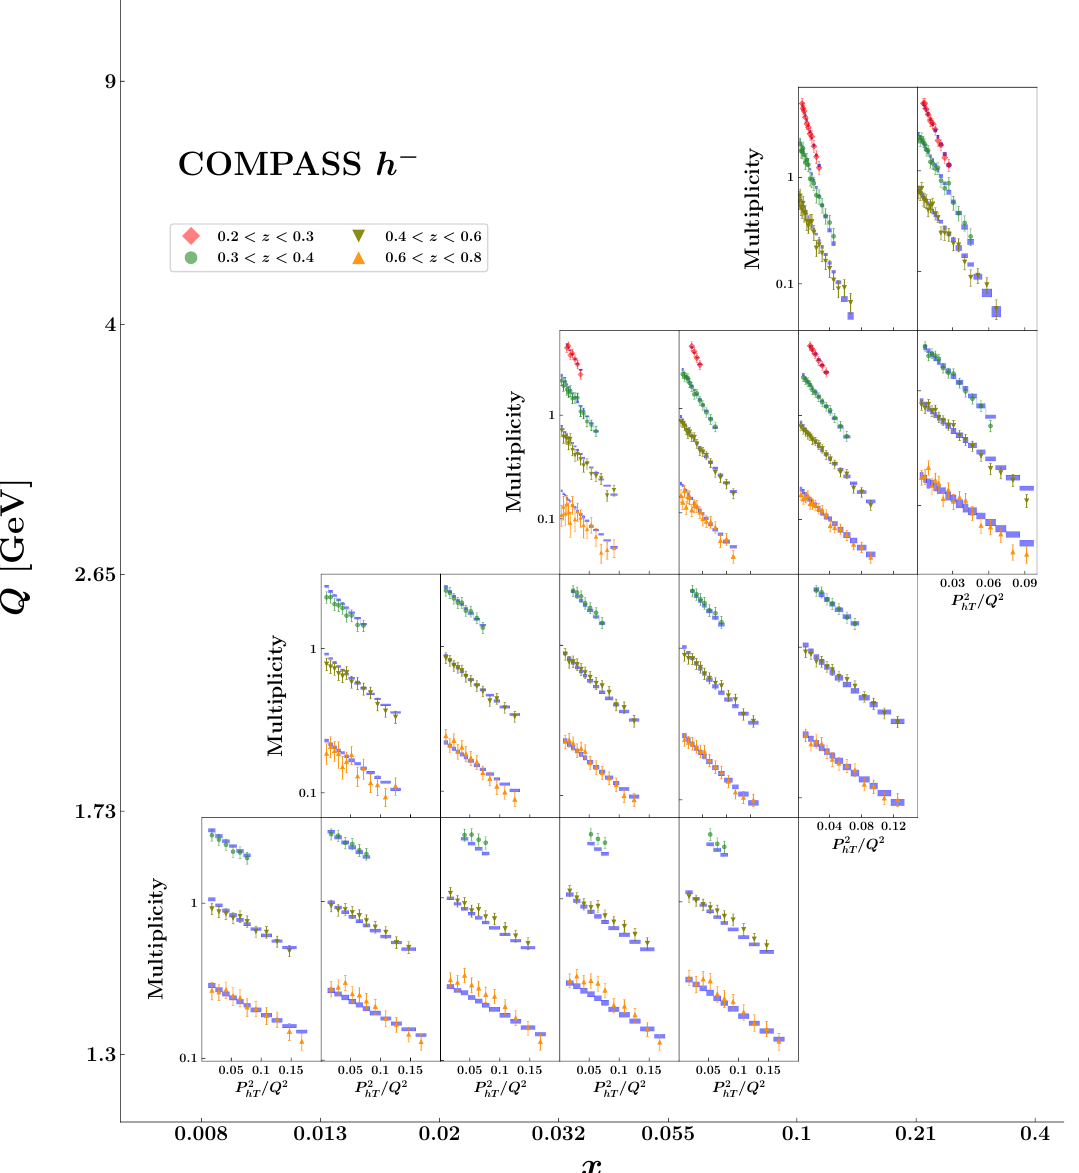
Figure 6 . Comparison between data and theoretical predictions for the COMPASS multiplicities for the production of negatively charged hadrons off a deuteron target. For each Q, x bin, the multiplicities are displayed as functions of P 2 /Q 2 for different z bins surviving kinematic cuts, as hT indicated in the